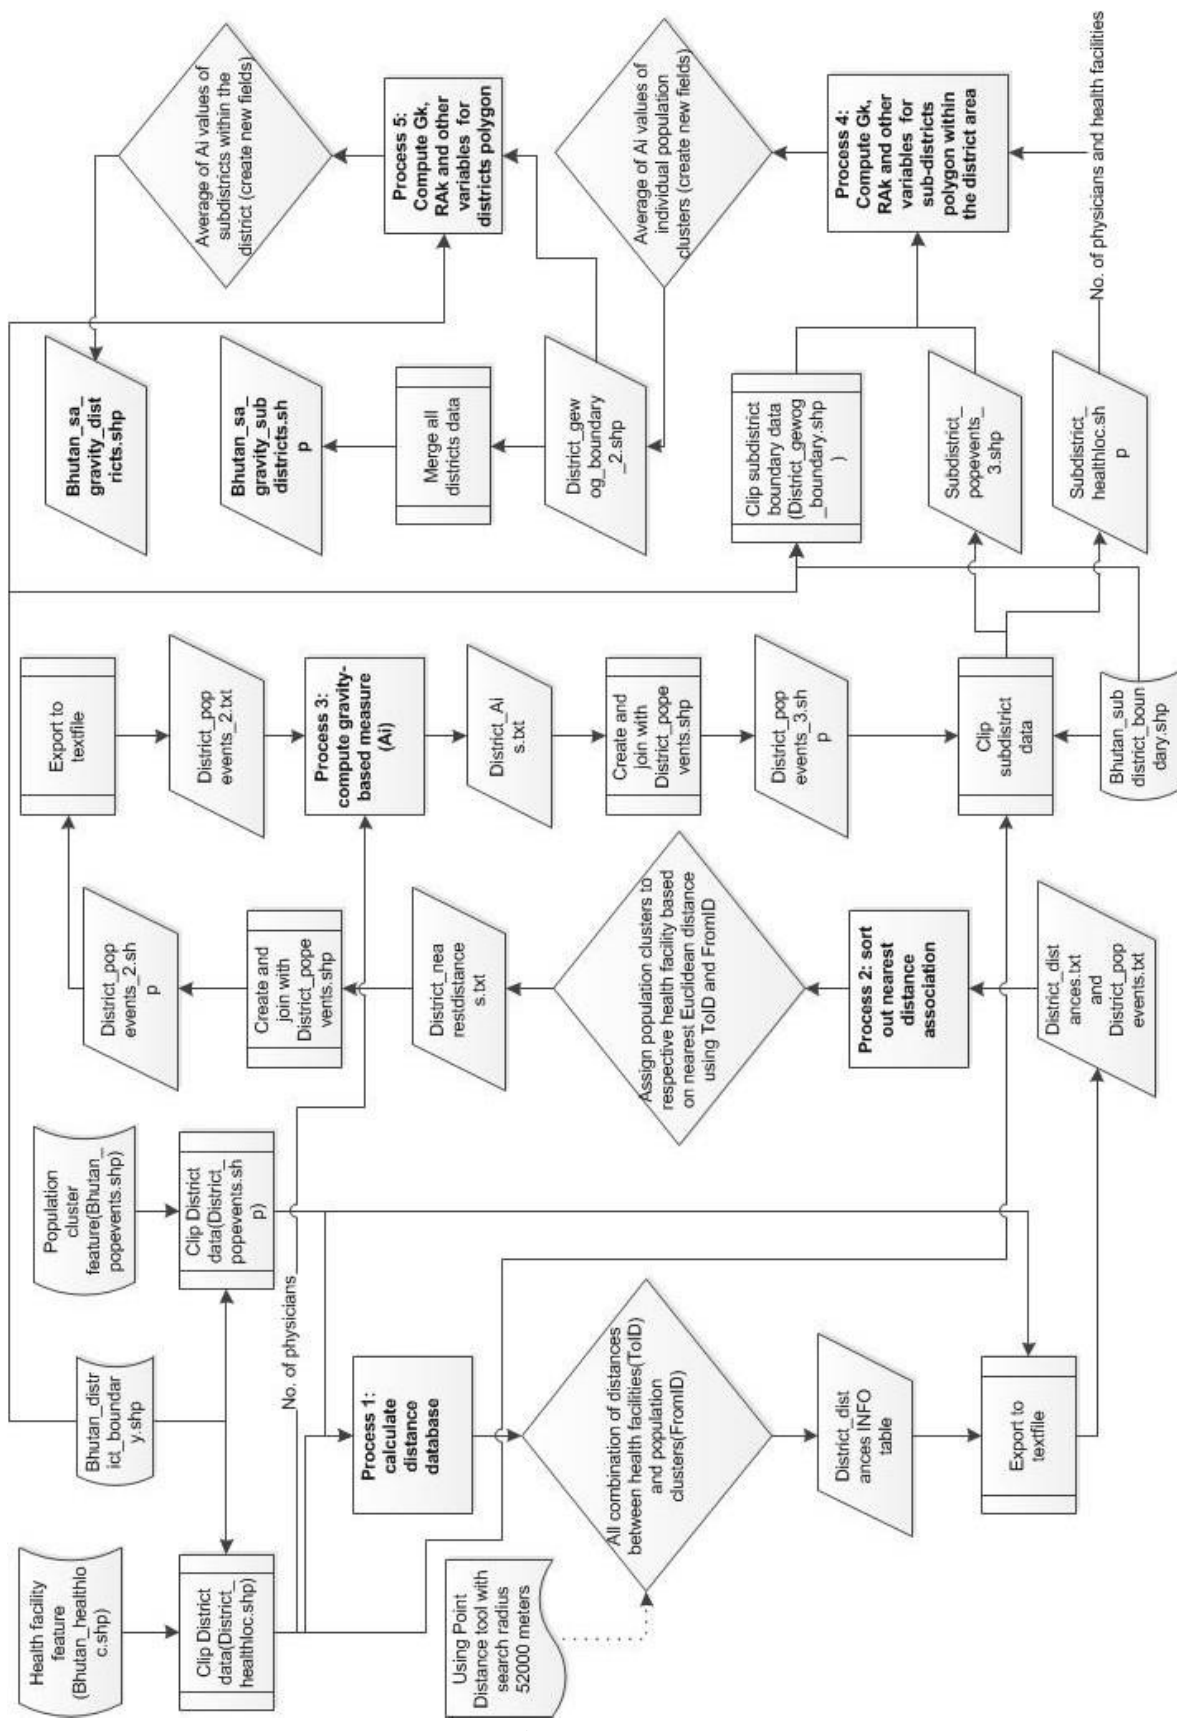
Figure 6: Processing steps for computing the spatial accessibility